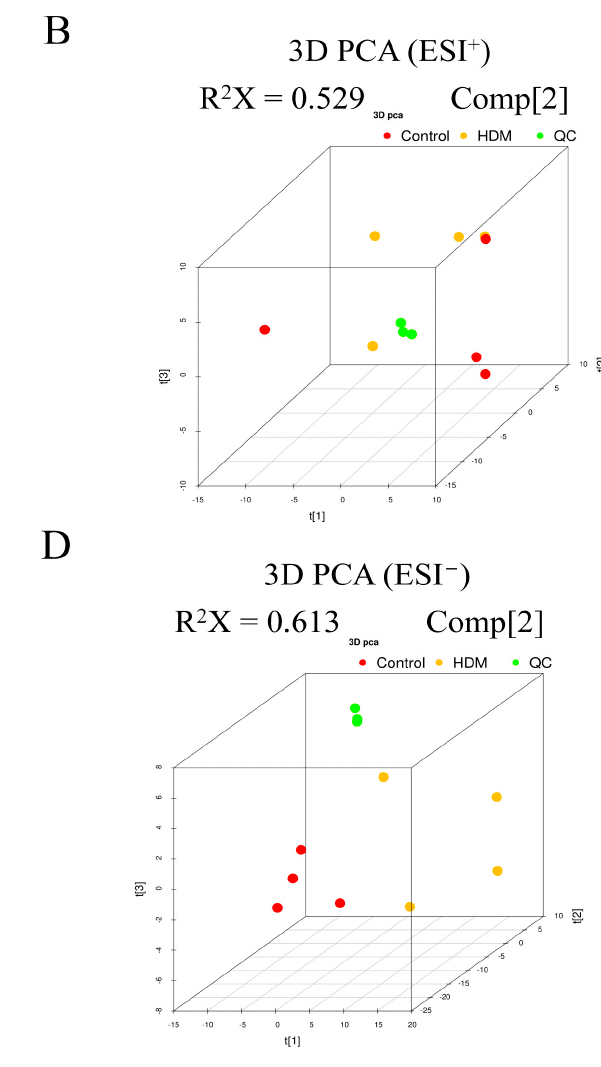
Figure 6. Principal component analysis (PCA) of metabolomic data. All samples in ESI+ modes are distributed in 2-dimensional plot ( A ) and in 3-dimensional plot ( B ). All samples in ESI − modes are distributed in 2-dimensional plot ( C ) and in 3-dimensional plot ( D ).